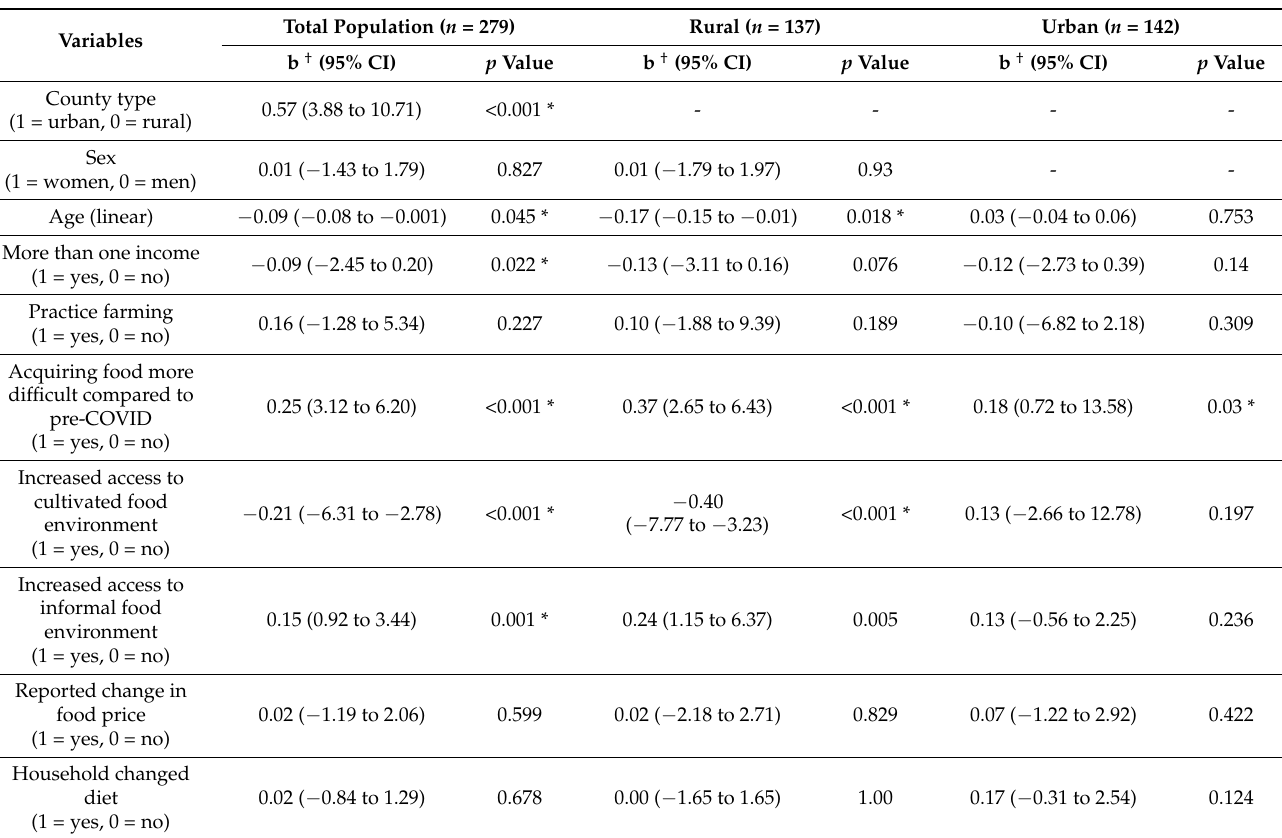
Table 6. Linear regression model for factors in relation to Household Food Insecurity Access Scale score in rural and urban